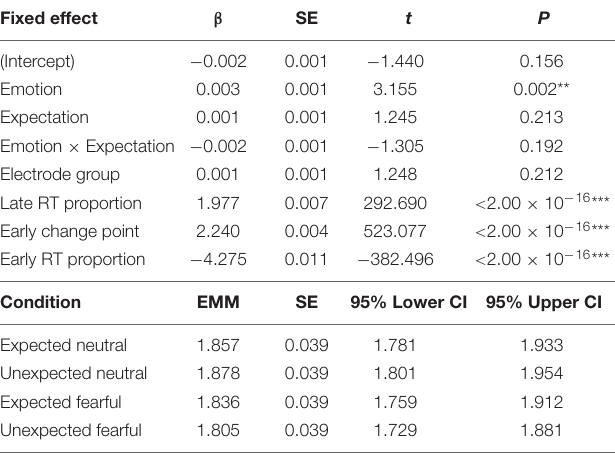
The results from two linear mixed effects models of neural change points (formula displayed in top row) for early (top half) and late (bottom half). The top section displays the statistics for each fixed effect ( β = coefficient estimate, SE = standard error) and the bottom section displays the estimated marginal mean (EMM;